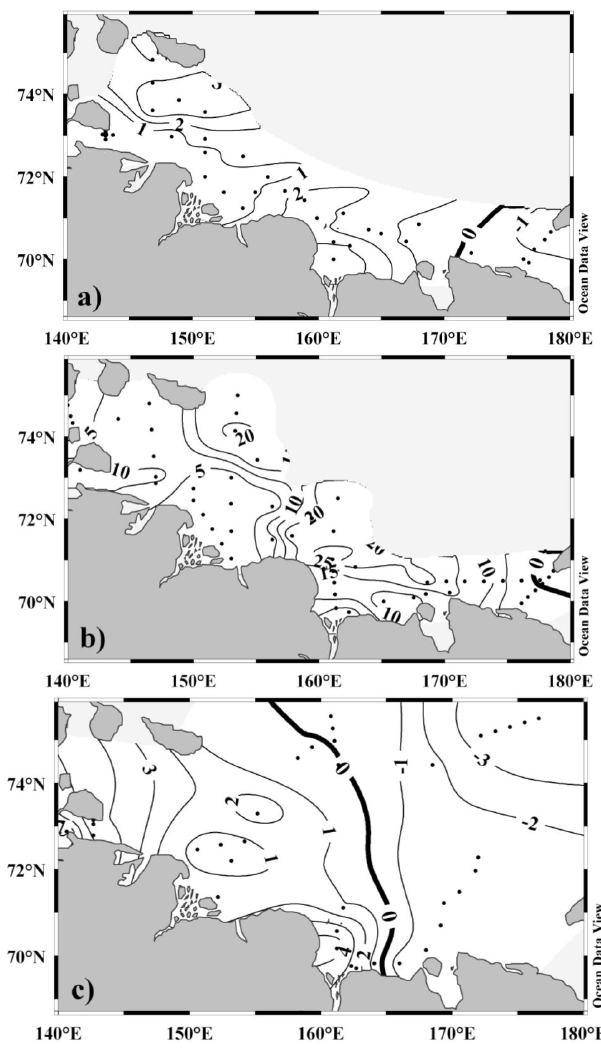
Fig. 9. Spatial distributions of air-sea CO 2 fluxes (mmolm − 2 day − 1 ) over the ESS shelf during the 2003 (a) , 2004 (b) , and 2008 (c) surveys (“+” – evasion, “ − ” –